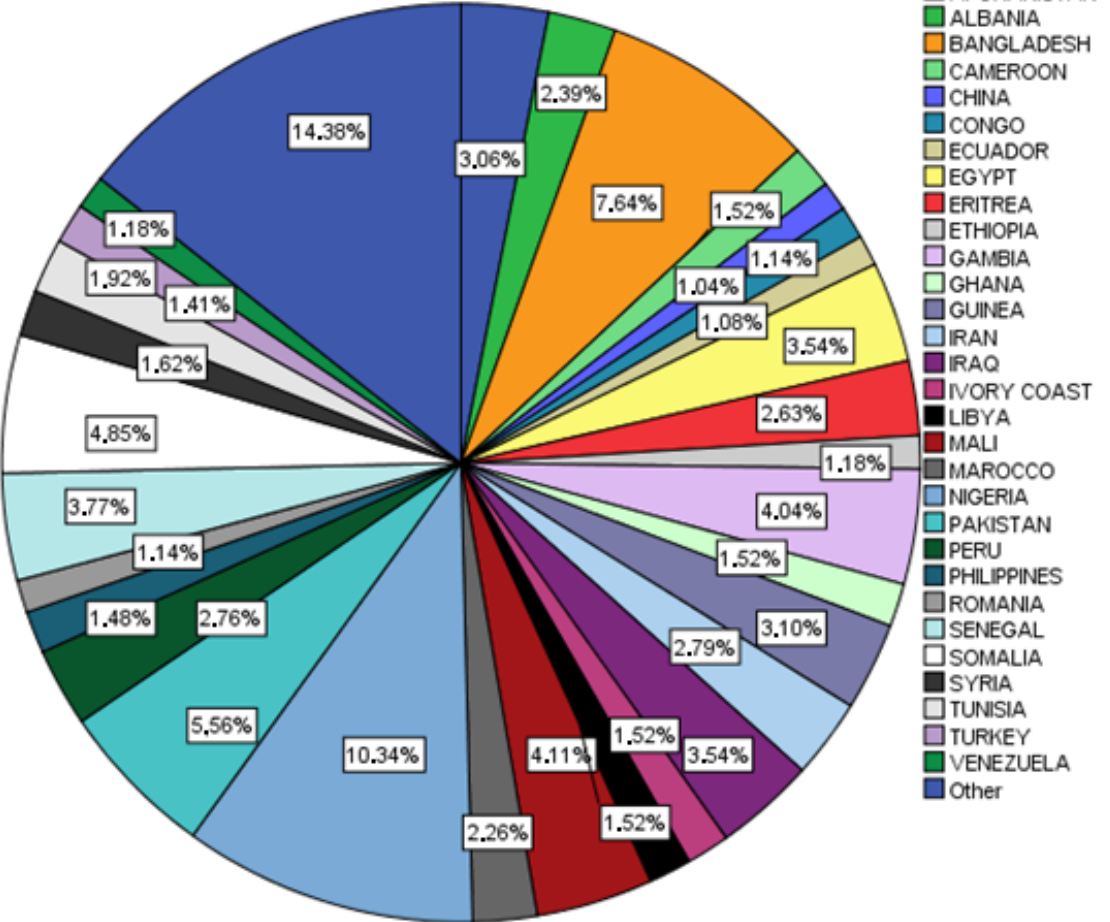
Figure 1. Percentage of subjects coming from different countries.